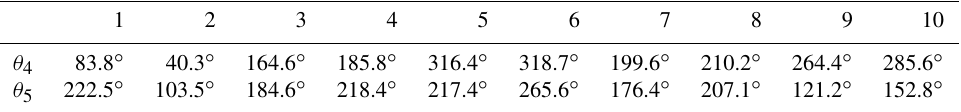
Table 6. Branch points in Example